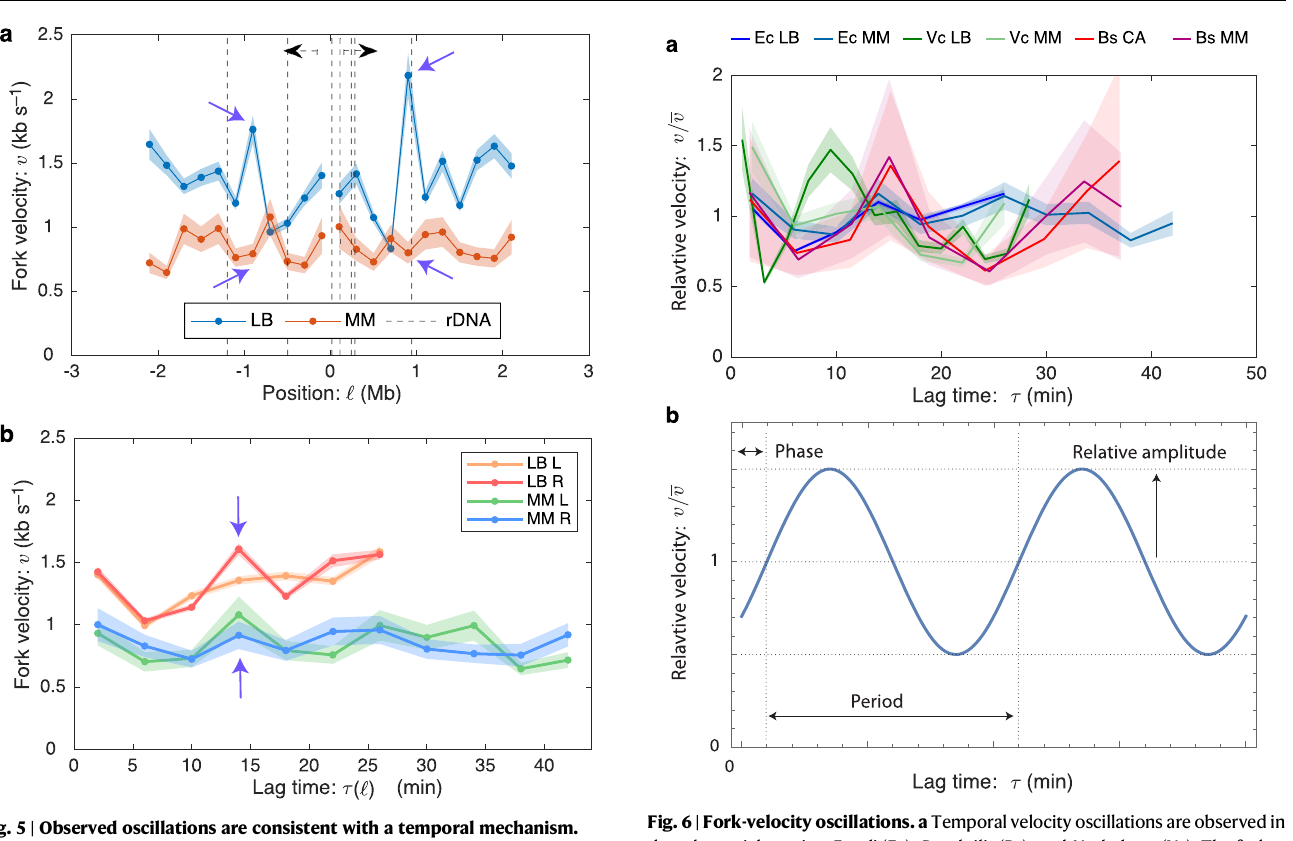
Fig. 5 | Observed oscillations are consistent with a temporal mechanism. a Velocityoscillationswithrespecttopositionin E.coli .Wecompareforkvelocities as a function of genomic position (with respect to oriC ) under rapid (LB) and slow (minimalmedia--MM)growthconditions.Motivatedbycon fl ict-inducedpauses,we have annotated the rDNA positions; however, slow velocities are not consistently coincident with rDNA loci. Regions with high fork velocities are not consistent between rapid and slow growth. E.g., see the purple arrows. Data are presented as mean values±SEM. b Velocity oscillations with respect to lag time in E. coli . The velocitypro fi leshavesigni fi cantbilateralsymmetry:therightandleftarmvelocities oscillate up and down together. Furthermore, not only are the oscillations con- sistentbetweenleftandrightarms,theyarealsoconsistentbetweenrapid(LB)and slow growth (minimal media--MM). E.g., see the purple arrows. Data are presented as mean